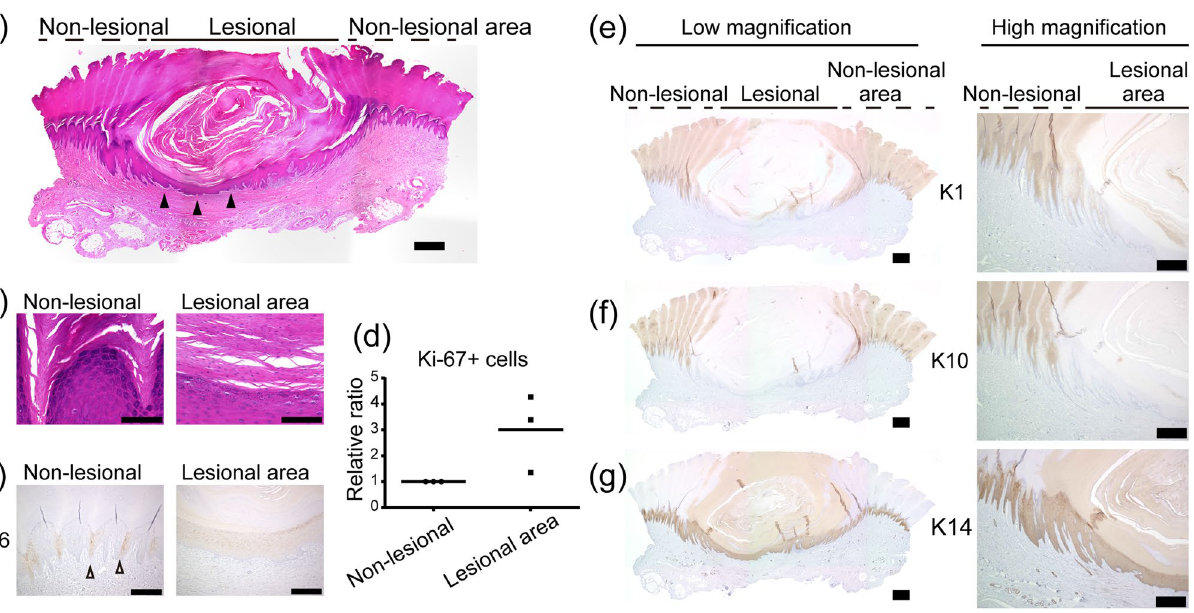
Figure 6. Histopathology of human corn ( a , b ) H&E staining. Scale bar: 1 mm ( a ) and 100 µ m ( b ). ( c ) K6 labeling. Scale bar: 300 µ m . ( d ) Quantification of Ki-67+ cells in the epidermis. ( e – g ) K1, K10, and K14 labeling. Scale bar: 1 mm (low magnification) and 500 µ m (high